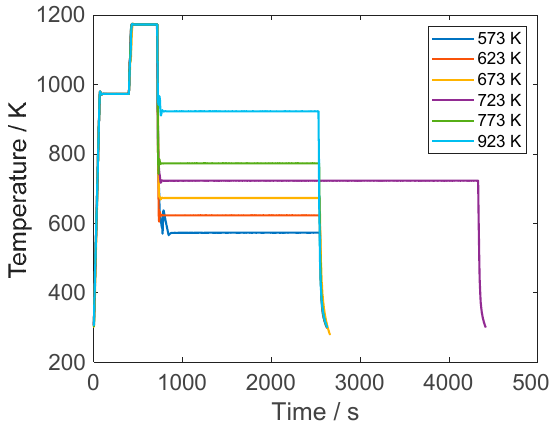
Figure 3. Heating schemes applied in this study.